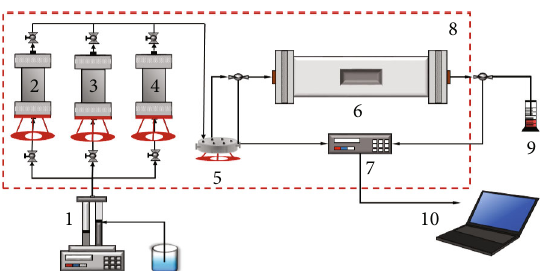
Figure 1: One-dimensional sand-packed model for EOR. 1: ISCO pump; 2: heavy oil; 3: polymer solution; 4: NaCl solution; 5: valves; 6: one-dimensional sand packed model; 7: pressure acquisition system; 8: constant temperature box; 9: sample